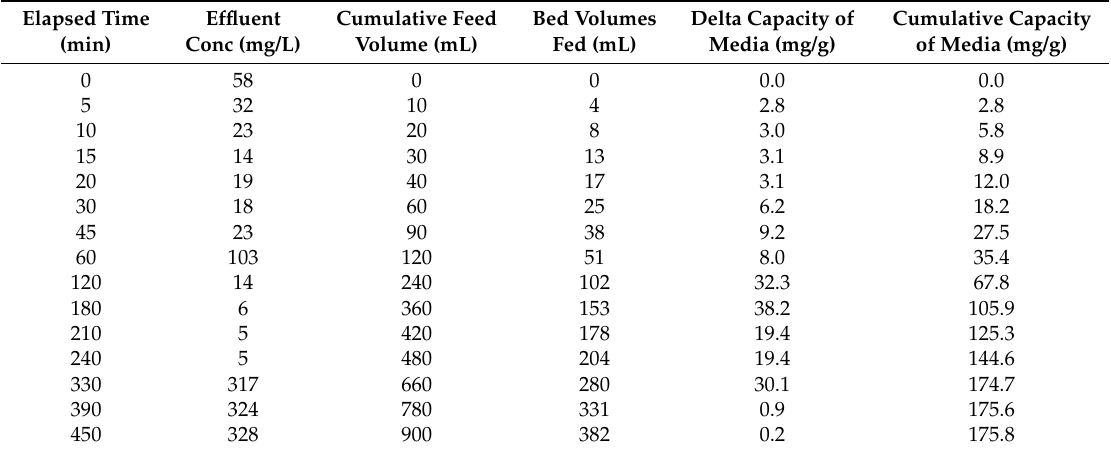
Table 3. Cumulative capacity of PCL/Ba (10/90) composite in the presence of SO 4 and NOM (Influent Concentration of sulfate: 328 mg/L and Flow rate: 2.0 mL/min).